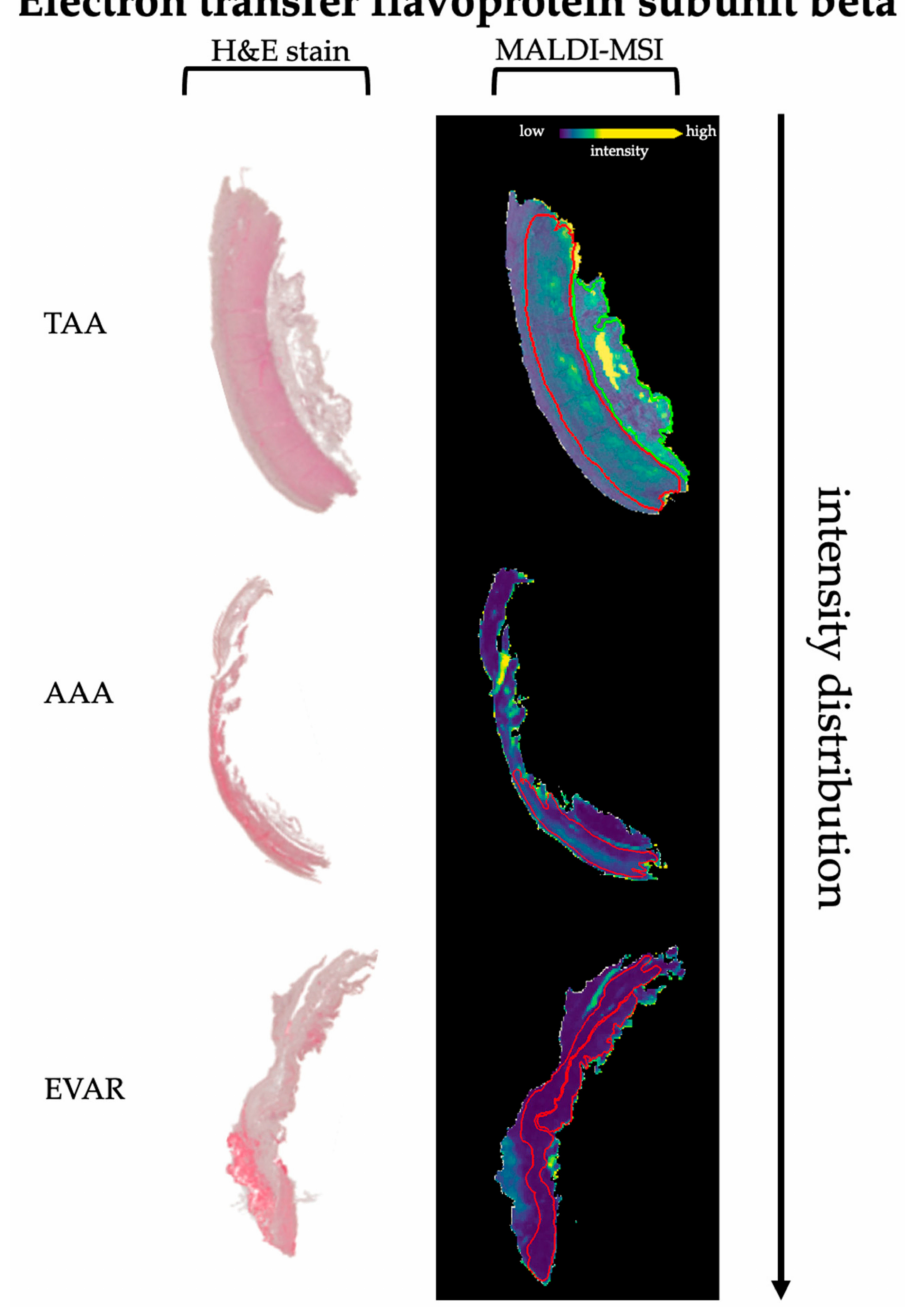
Figure 2. Differential intensity distributions of electron transfer flavoprotein subunit beta between TAA, AAA, and EVAR